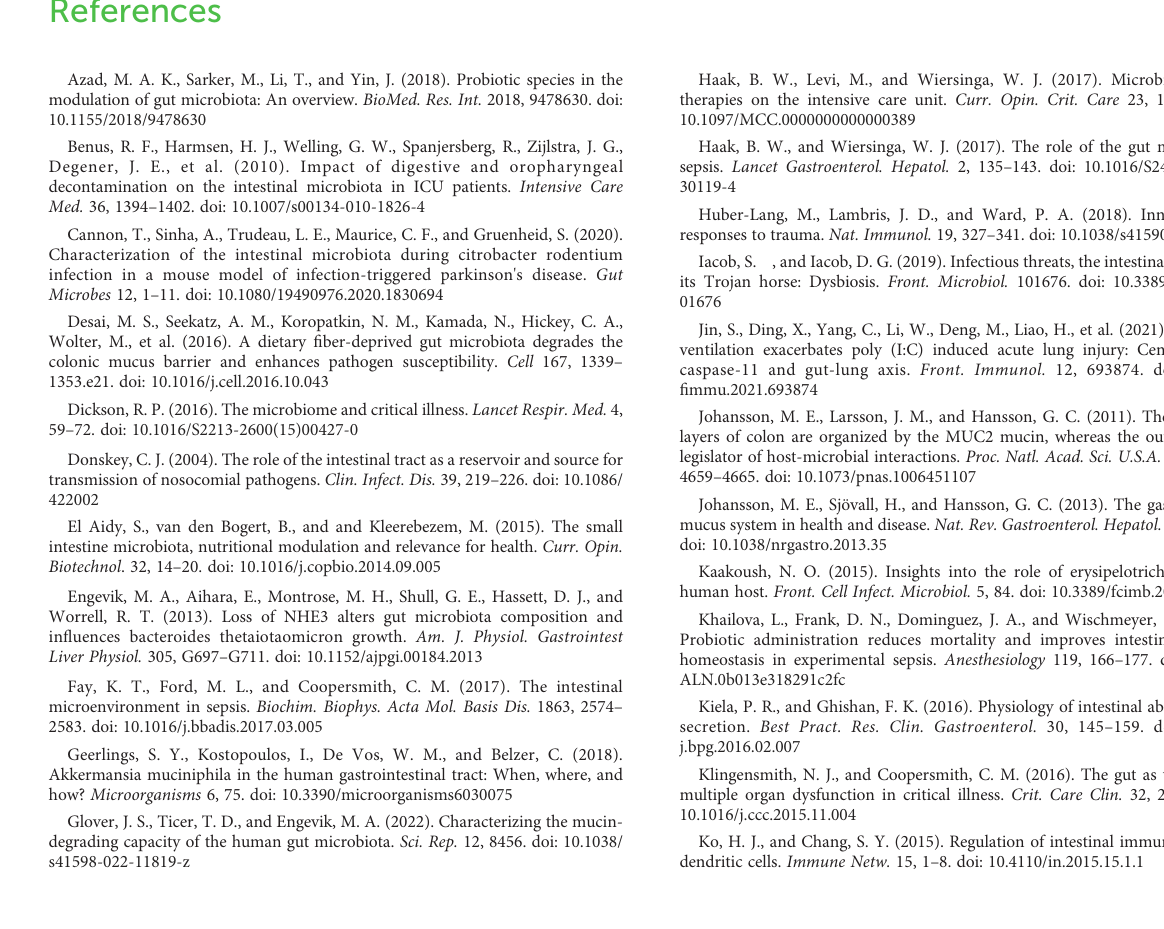
SUPPLEMENTARY TABLE S4 Changes in the abundance of the microbiota in different intestinal segments in the sham group.